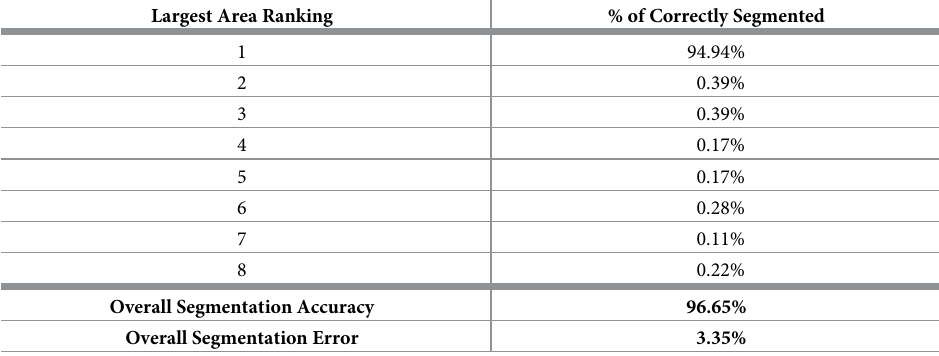
Table 5. Segmentation accuracy for the eight largest areas found by the image segmentation stage. Ranking 1 rep- resents the largest area, ranking 2 represents the second largest area and so on.